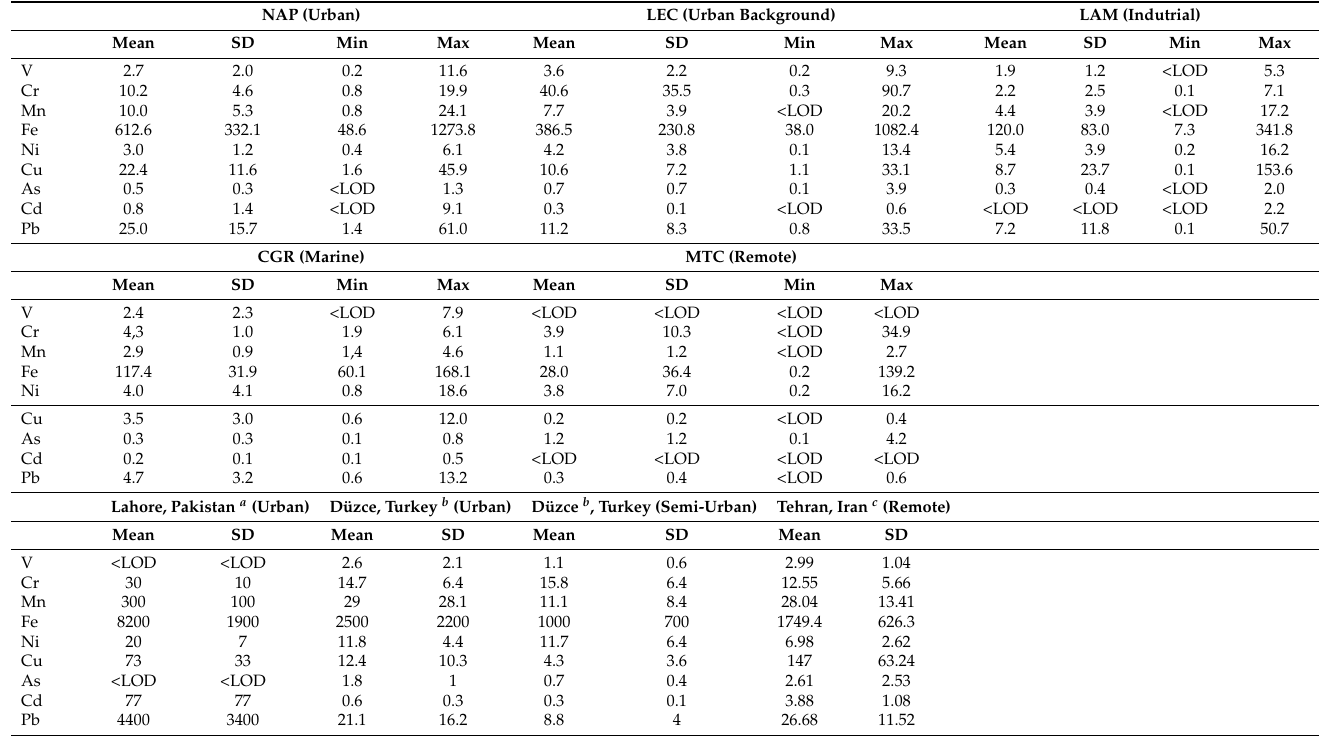
Table 4. The mean, minimum, maximum and standard deviations (SD) of the element concentrations in PM 10 : the concentrations are in ng/m 3 ; LOD, limit of detection; NAP, Naples; LEC, Lecce; LAM, Lamezia Terme; CGR, Capo Granitola; MTC, Monte Curcio. a [75]; b [76]; c [74].